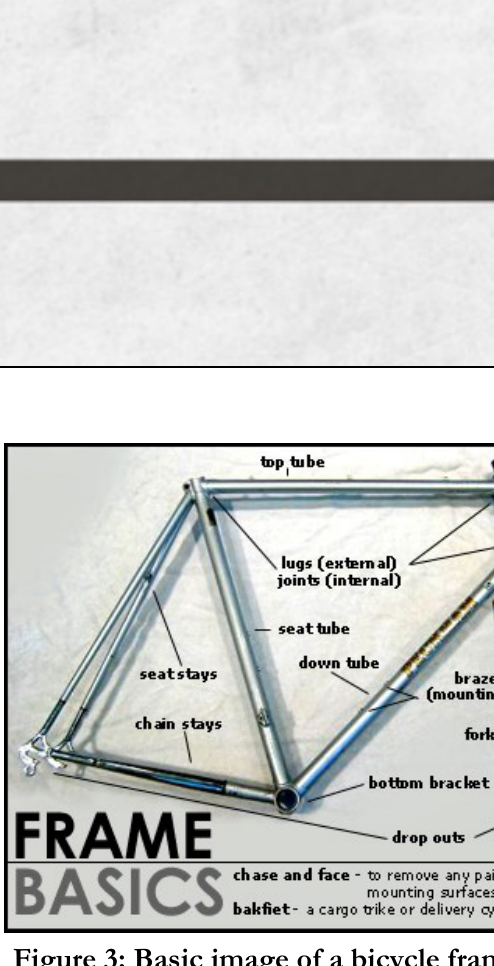
Figure 3: Basic image of a bicycle frame Source: Bloodline , Angles and